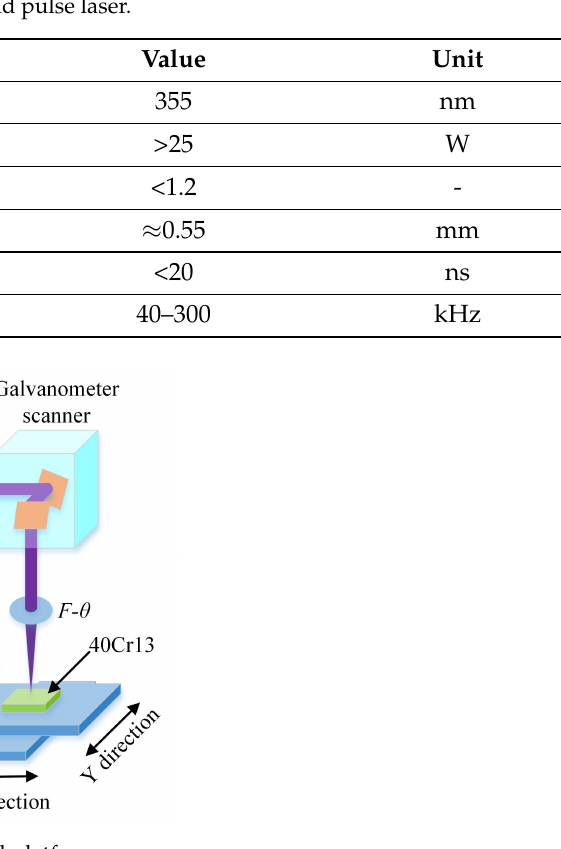
Figure 1. Schematic of the experimental platform.